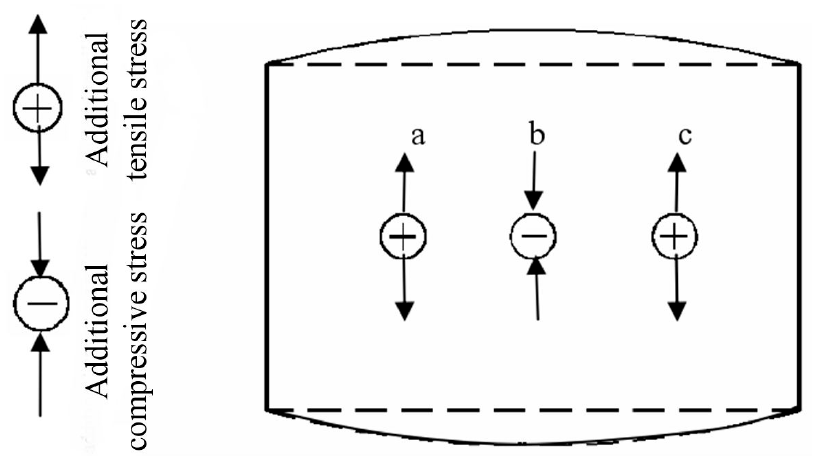
Figure 2. The schematic of longitude bending.